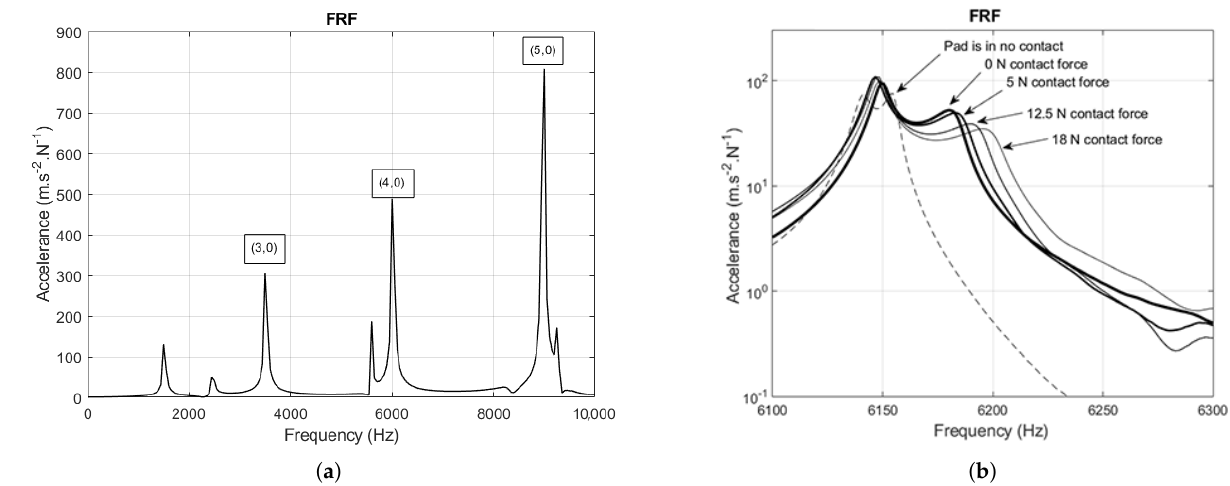
Figure 5. ( a ) Averaged FRF of the free disc with highlighted mode shapes and ( b ) comparison of FRF of the attached disc with di ff erent pad loading variations in the 5800–6200 Hz region.